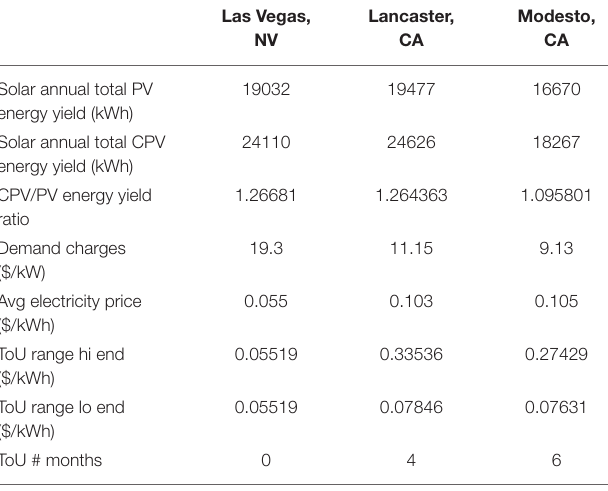
TABLE 3 | Energy yield for 270 kW DC solar installations and medium sized business tariffs. Las Vegas, NV FIGURE 3 | Time of use tariffs ($/kWh) in (A) Lancaster, CA, and (B) Modesto,